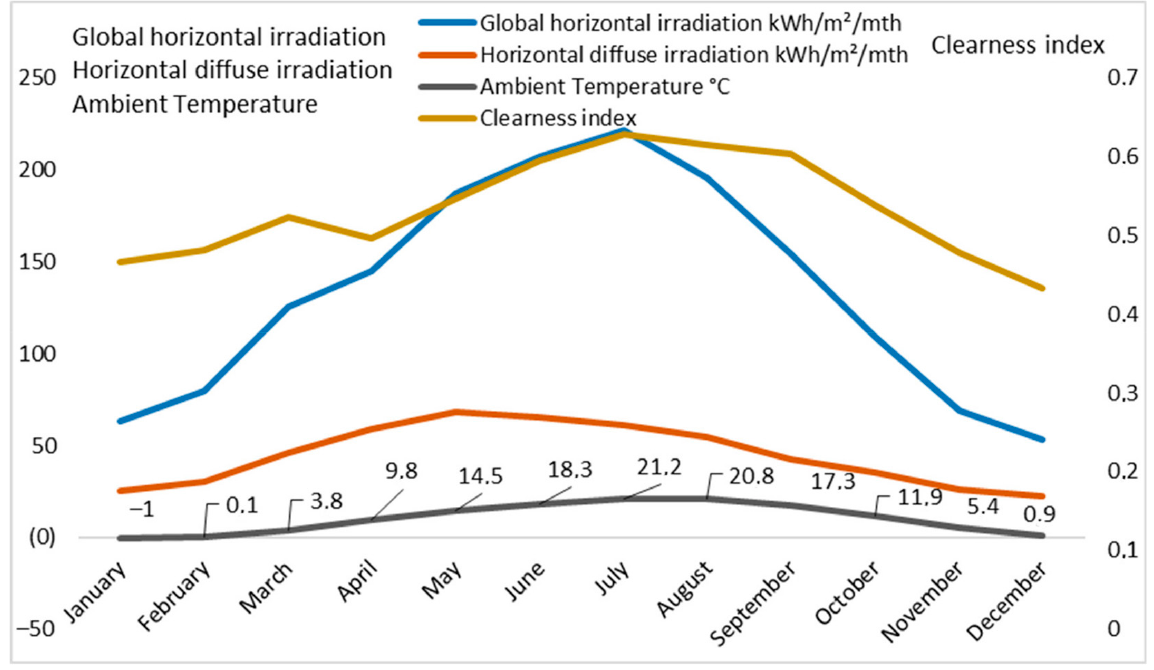
Figure 4. Realistic resource data of the study area.